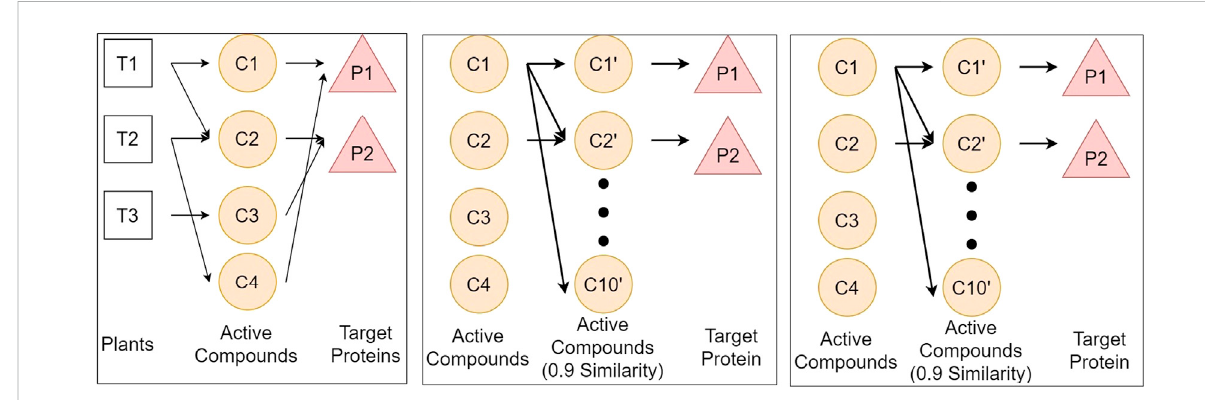
FIGURE 1 Illustration of three networks of plants, compounds, and proteins, respectively represented by T, C, and P. We de fi ne three networks from differentdatabasestogettherelationshipbetweenplantsandprotein.NetworkAconnectsplantsfromKNApSAcK,compoundsfromKNApSAcKand PubChem, and proteins from PubChem BioAssay. Network B connects compounds in network A, compounds in network B taken from ChemmineTools, and thetargetprotein isthesame as that inNetwork A.NetworkC connectsproteins from Usman etal. (2020), proteins from Uniprot, and compounds from PubChem BioAssay.